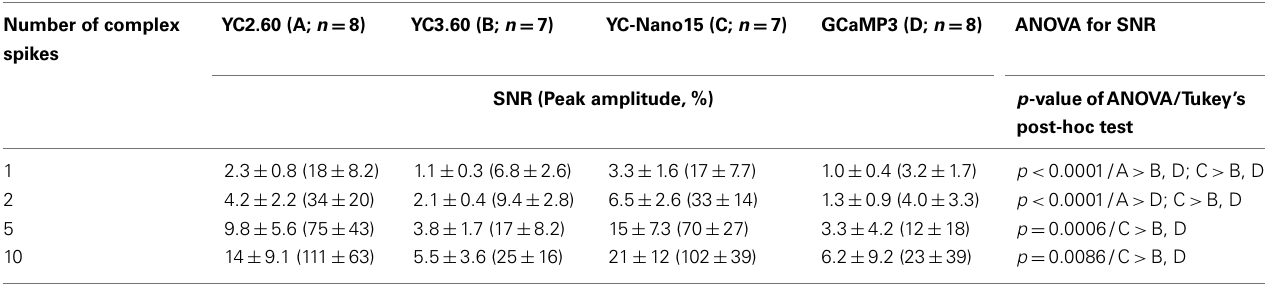
Table 4 | Responses of GECIs in cerebellar Purkinje